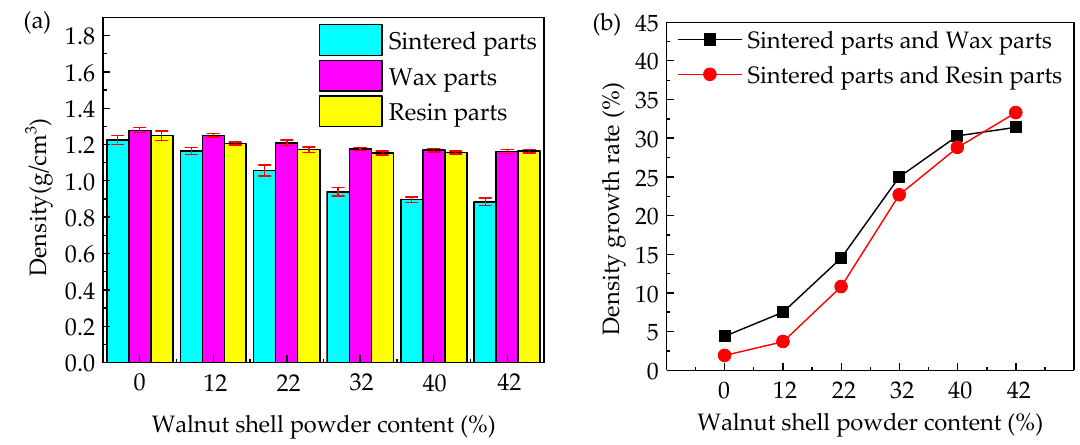
Figure 6. The density changes and growth rate curves of WSPC parts and after-treatment parts with different ingredient proportions: ( a ) density bar chart; and ( b ) density growth rate curves.